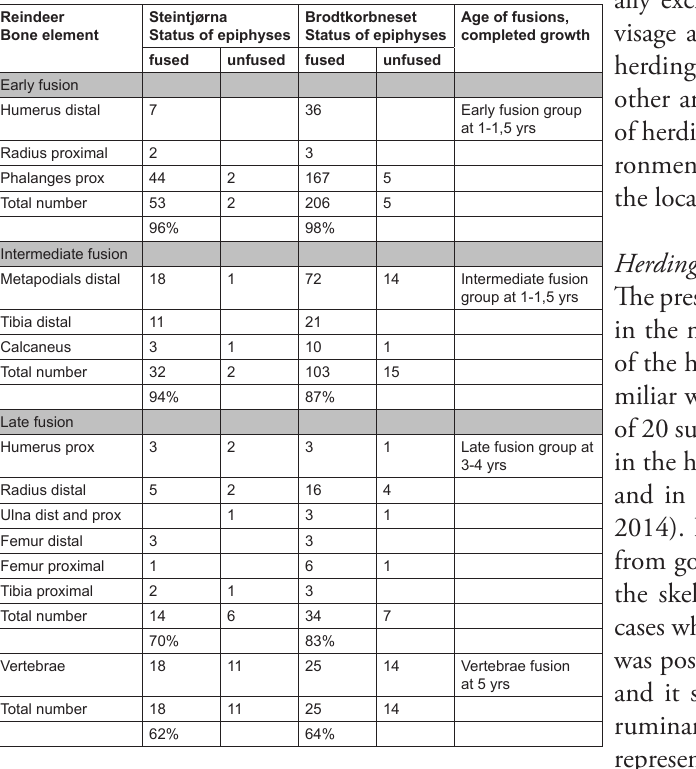
Table 6. Epiphysis fusion divided into three age groups based on if the epiphyses of different bones has early fusion, intermediate fu- sion or late fusion. Unfused epiphyses mean that the bone element is still growing. When fused the growing has stopped. The number of fused or unfused epiphyses of the different bone elements found in the hearths was recorded. The proportion between fused and un- fused observations reveals the rate of survival at a certain age. More than 60% of the reindeers were at least 5 years when slaughtered or killed. Bone element age of fusion after Hufthammer